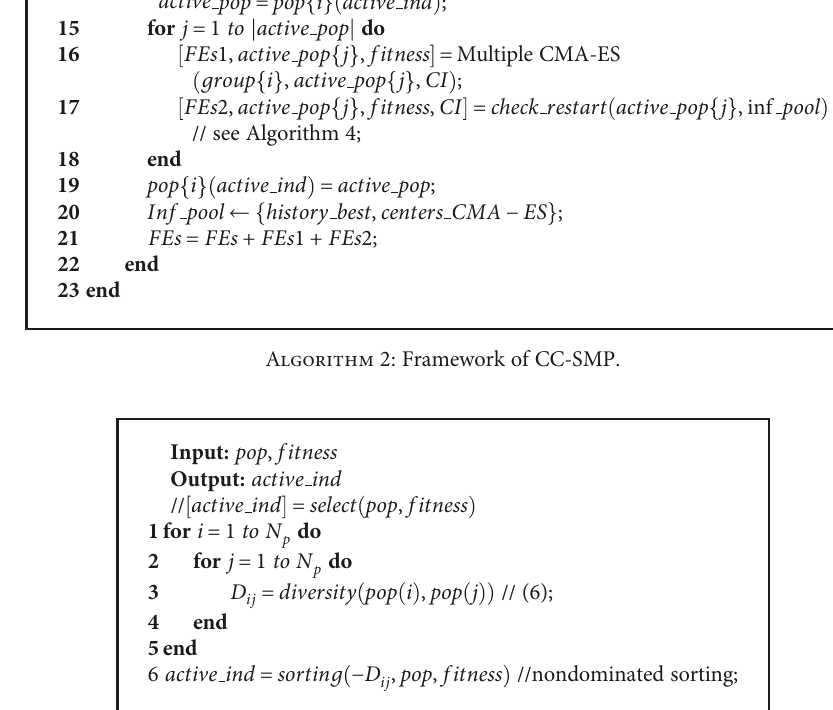
Algorithm 3: Select Active